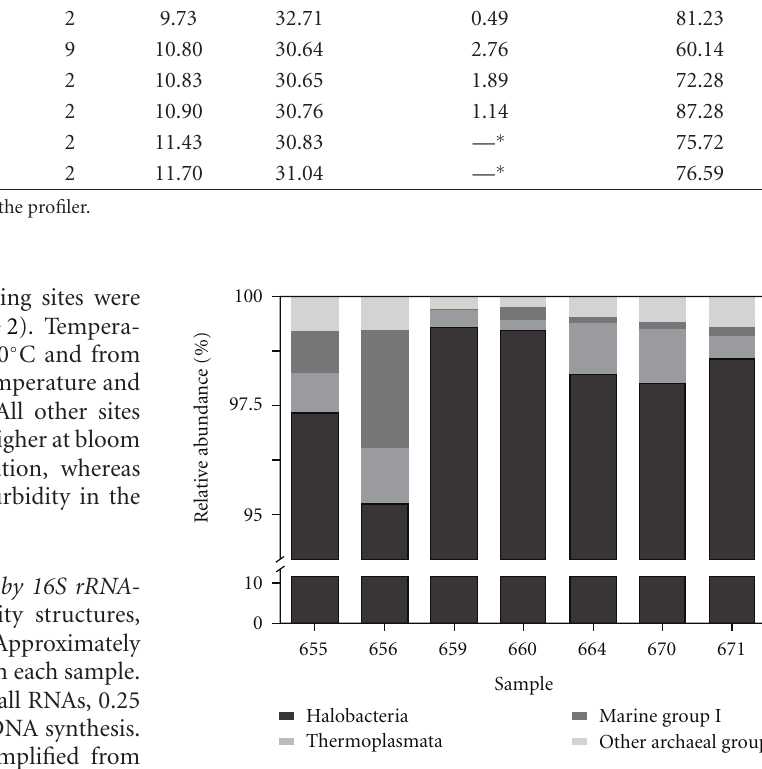
Figure 2: Relative sequence abundances of di ff erent archaeal phyla and classes. Euryarchaeota , especially Halobacteria (98.14%), were highly abundant. Thermoplasmata (0.75%) and the Marine Group 1 (0.58%) were found to some extent. All archaeal classes and groups (abundance < 0.5%) are depicted